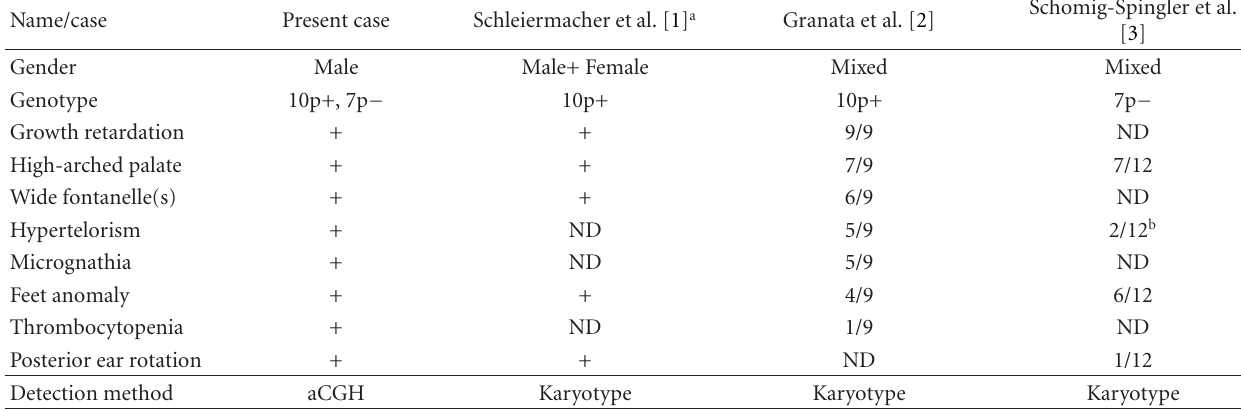
Table 1: Phenotypic findings in our patient and patients reported in the literature with either pure trisomy 10p11.2p15.3 or monosomy